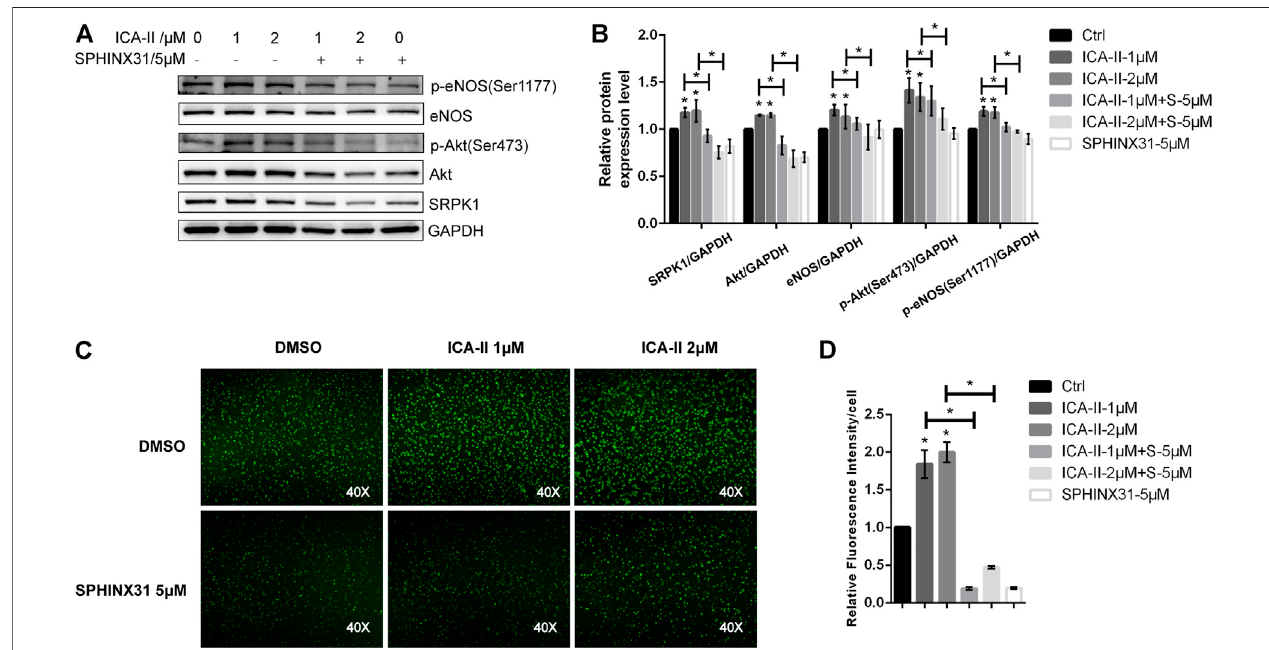
FIGURE6| ActivationofSRPK1-Akt-eNOSpathwayinHUVECstreatedwithICA Ⅱ .HUVECsweretreatedwithdifferentconcentrationsofICA Ⅱ (1and2 μ M)inthe presence or absence of SPHINX31 (5 μ M) for 24 h. The levels of eNOS, phosphor-eNOS (Ser1177), Akt, phosphor-Akt (Ser473), and SRPK1 were determined by westernblot (A) withthequanti fi cationsoftherelatedproteins (B) .Afterthesametreatment,theimmuno fl uorescenceimagesoftheNOprobewereobservedusing40× fl uorescence microscopy (C) with the quanti fi cations of mean fl uorescence intensity (D) . The data are presented as the mean ± SD of three independent experiments. Signi fi cance was determined by one-way ANOVA with a least signi fi cant difference post hoc test. ns, p > 0.05; *, p < 0.05 vs Ctrl.